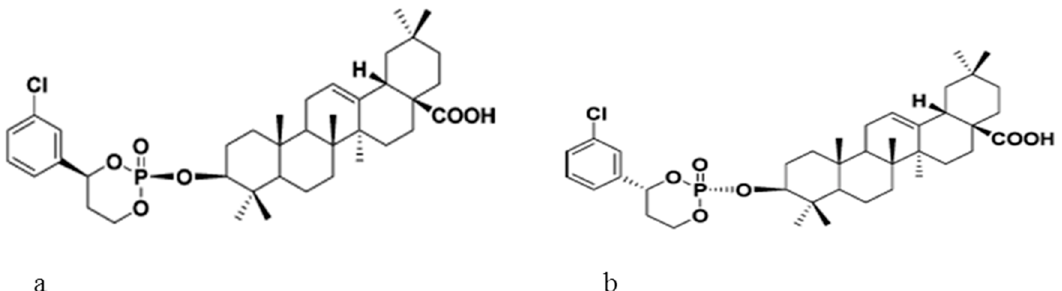
Figure 3. Two novel oleanolic acid prodrugs: ( a ) cis -3- O -[4-( R )-(3-chlorophenyl)-2-oxo-1,3,2- dioxaphosphorinan-2-yl]-oleanolic acid ( b ) cis -3- O -[4-( S )-(3-chlorophenyl)-2-oxo-1,3,2-dioxa- phosphorinan-2-yl]oleanolic acid